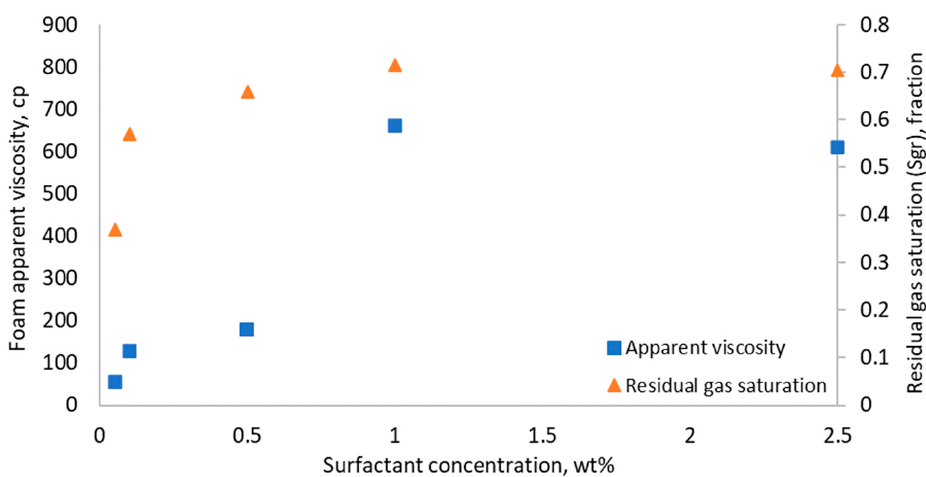
Figure 12. Final residual gas saturation (due to SAG injection followed by imbibition) as a function of surfactant concentrations for sample AC and sample B.